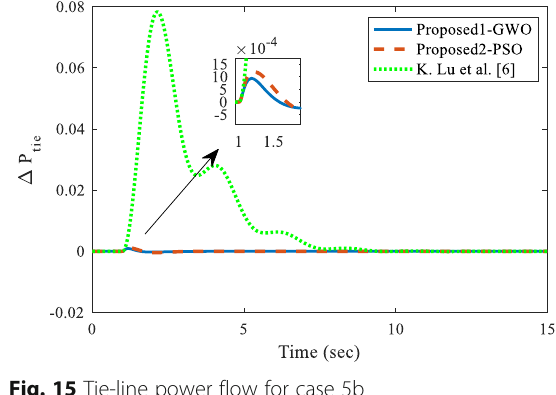
Fig. 15 Tie-line power flow for case 5b